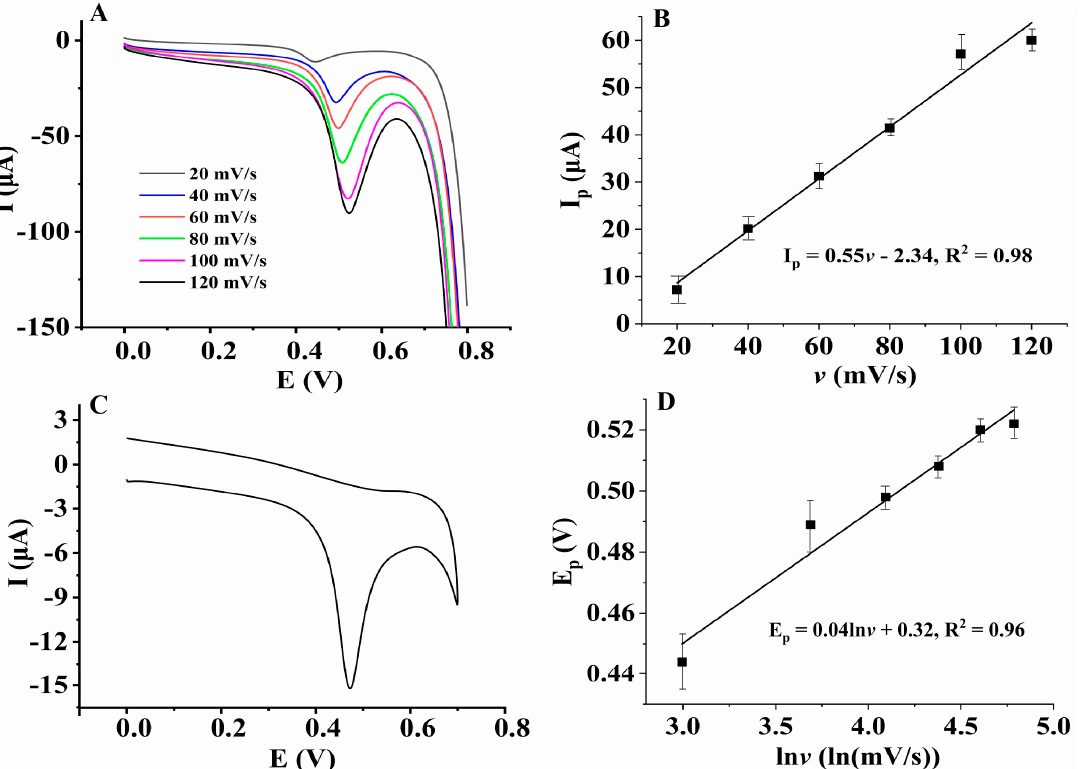
Figure 6. ( A ) Linear sweep voltammograms of 200 µ M HcySH on AuNPs/AB–DHP/GCE in 0.15 M PBS (pH = 6.0) with different scan rates. ( B ) Linear relationship between the oxidation peak current of HcySH and scan rate. ( C ) Cyclic voltammogram of 200 µ M HcySH on AuNPs/AB–DHP/GCE in 0.15 M PBS (pH = 6.0). ( D ) Linear relationship between the oxidation peak potential of HcySH and the natural logarithm of scan rate.